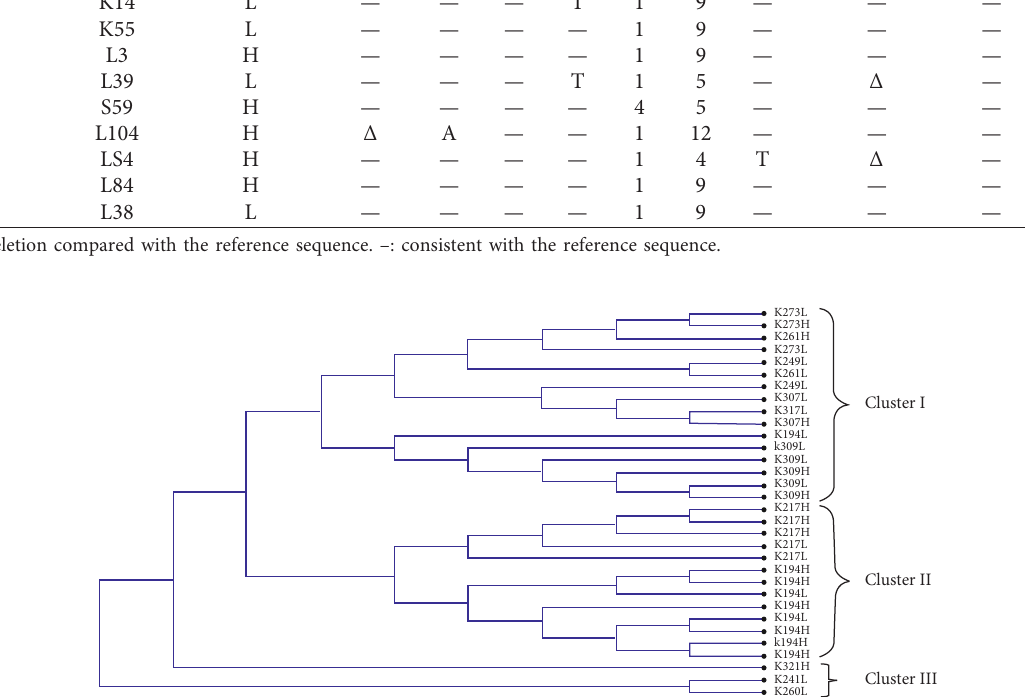
Figure 1: A neighbor-joining phylogenetic tree for Kuroiler LEI0258 DNA sequences generated by using the full likelihood distance and general reversible model. In branch name, K is Kuroiler; the number is allelic size in base pair (bp); H is high susceptible; and L is less susceptible.